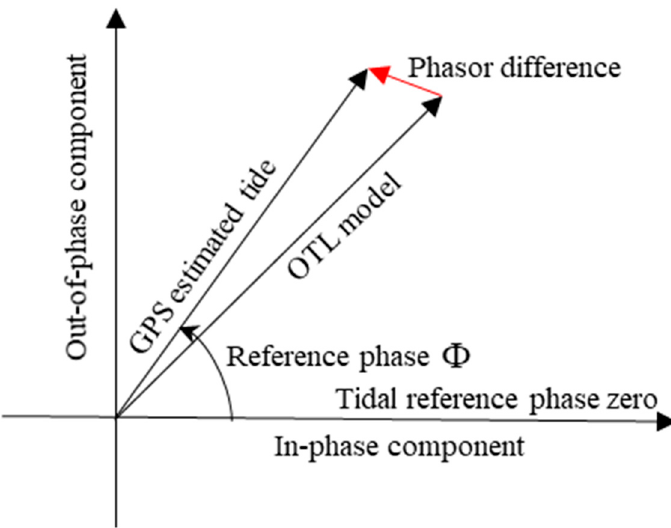
Figure 2. Phasor vector diagram of the relationship between the GPS estimate and OTL model.